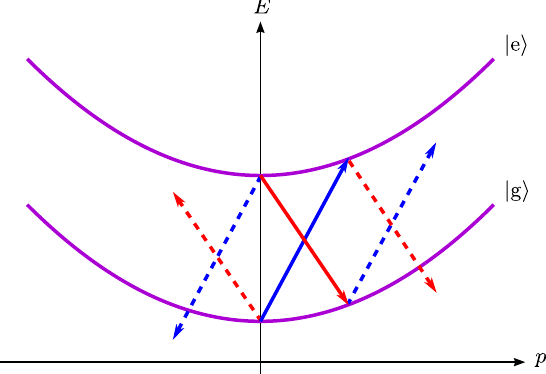
FIG. 14. Single-photon transitions between the clock states shown in an energy-momentum diagram that takes into account the internal energy and the c.m. motion (as described in the freely falling frame where the atoms are initially at rest). The frequen- cies of the two counterpropagating beams are shifted by ω − ω from the clock frequency ω 0 so that they drive resonant rec transitions of atoms initially at rest through absorption (blue arrow) and stimulated emission (red arrow), respectively. By applying simultaneous π = 2 pulses, one can generate an equal- amplitude superposition involving an undiffracted wave packet plus a diffracted one with swapped internal states and a single- photon momentum transfer. Relevant off-resonant transitions are additionally indicated with dashed lines.